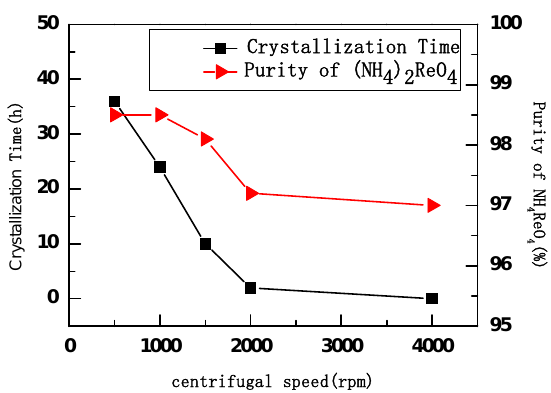
Figure 4. Centrifugal speed—conversion relation of crystallization time and purity.